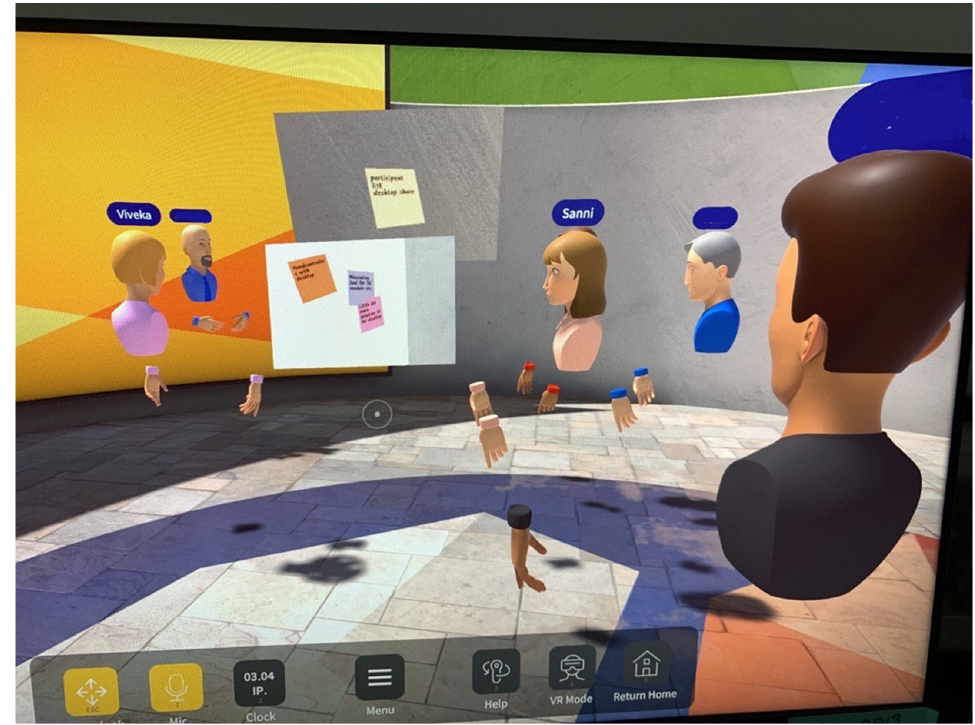
Figure 4. Snapshot of a laptop running Glue in desktop mode during a user test in Case 2. Test setup: In this session, we had a remote HMD facilitator inside the VR, three HMD participants, and three desktop participants. All participants were in different locations, safety of the HMD user in the same location (Figure 5).